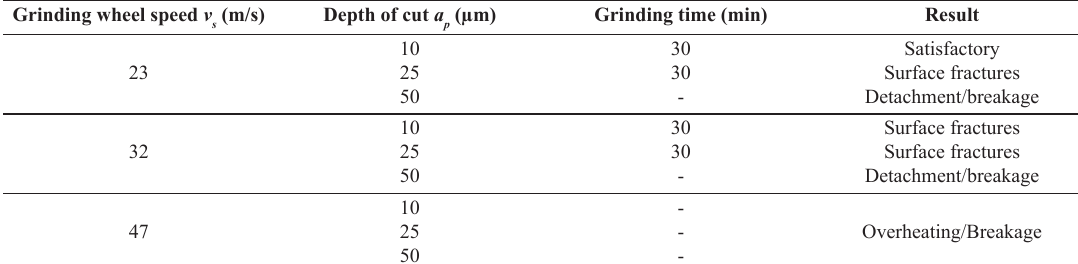
Table 3. Summary of the feasibility test results as a function of the different processing parameters. Grinding wheel speed v s